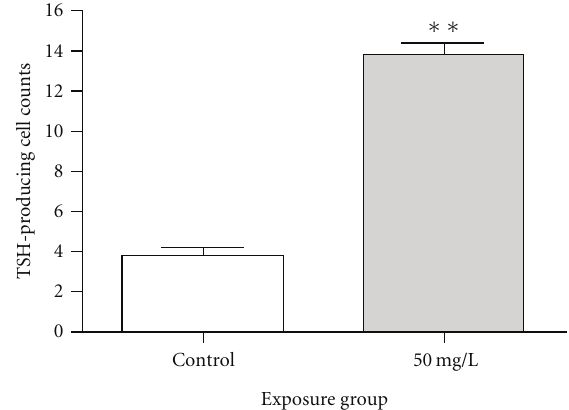
Figure 11: TSH-producing cell counts of zebrafish ( Danio rerio ) pituitaries after exposure to 0 and 50 mg/L PTU. Statistical analysis was conducted on five immunostained sections, respectively ( ∗∗ P < 0 . 01; Mann-Whitney